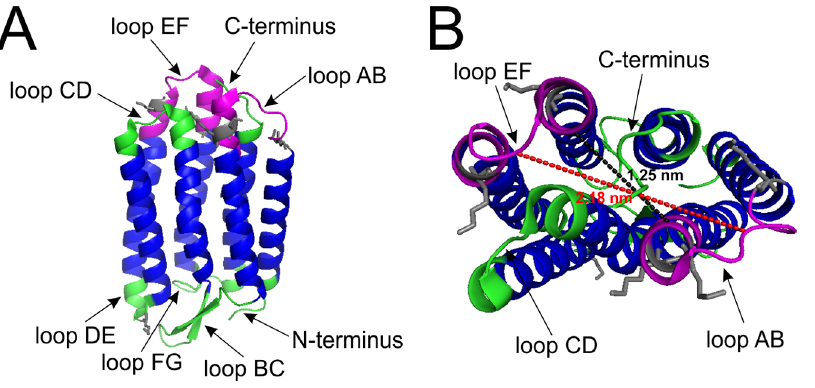
Figure 7. Crystal structure of bacteriorhodopsin (PDB accession number 1IW6). A shows a side view of bR and B a view from above. Transmembrane regions are shown in blue and extramembranous regions are shown in green and purple. Putative binding sites for the phage clones 43, 68 and 165 are highlighted in purple. Dotted lines indicate distances between residues of the loops AB and EF: black dotted line between the C a of the residues A38 and V167 (1.25 nm) and red dotted line between the C a of the residues V34 and M163 (2.18 nm). Lysine residues including their side chains are marked in grey. Structure visualization of bR was done with pymol.